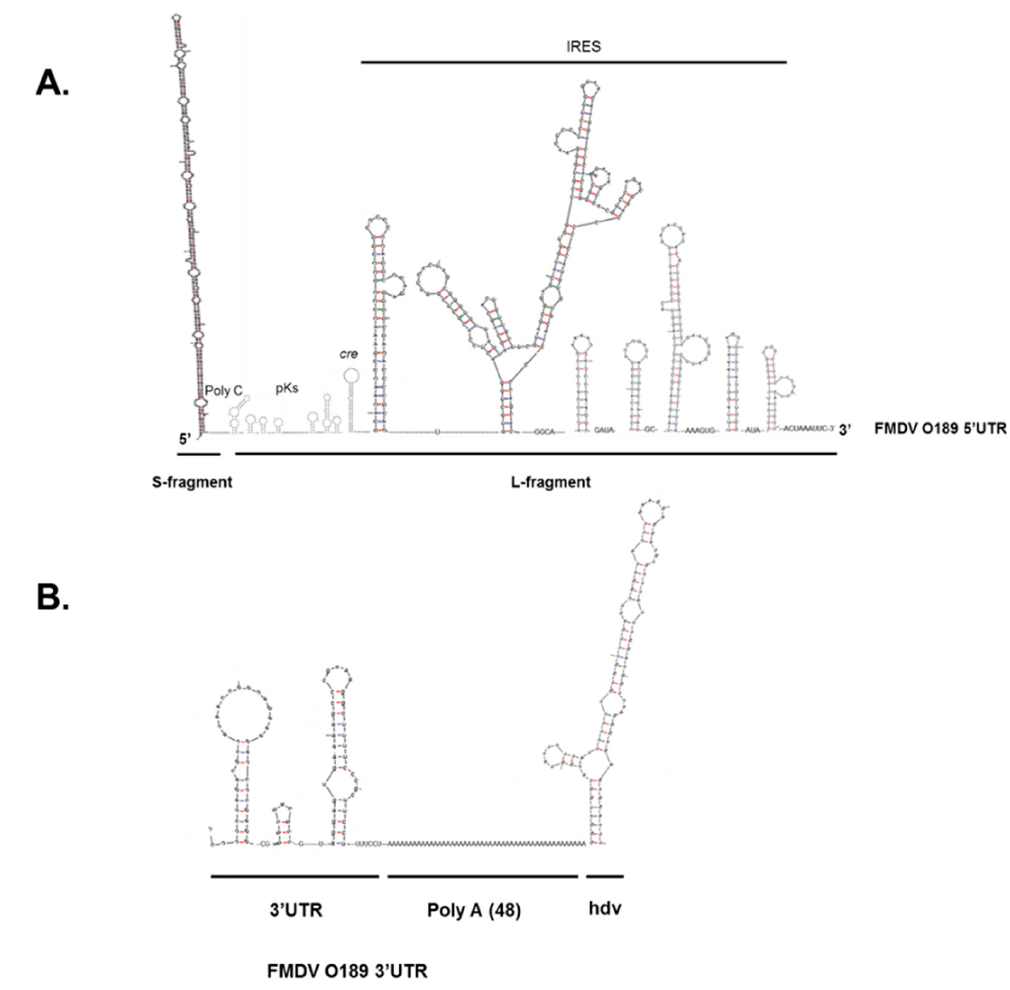
Figure 3. The regions of FMDV O189 UTRs and hdv ribozyme were used as the input sequences to generate the putative RNA secondary structures using mFold (RNA folding form version 2.3). ( A ) The 5 ′ UTR comprised 368 nucleotides of S-fragment that formed a long stem–loop, followed by an l-fragment. The l-fragment was composed of 14 residues of a poly C, pseudoknots (pKs), cre, and IRES elements in a 5 ′ to 3 ′ direction. The pseudoknots spanned 175 nucleotides, while cre contained a conserve AAACA motif. The IRES spanned the rest of 5 ′ UTR (located at 542–1053 nucleotides) upstream of the first start codon. ( B ) The 3 ′ UTR contained 92 nucleotides folding into two stem–loop structures. Downstream the 3 ′ UTR was a long poly A tail containing 48 adenine resi- dues.